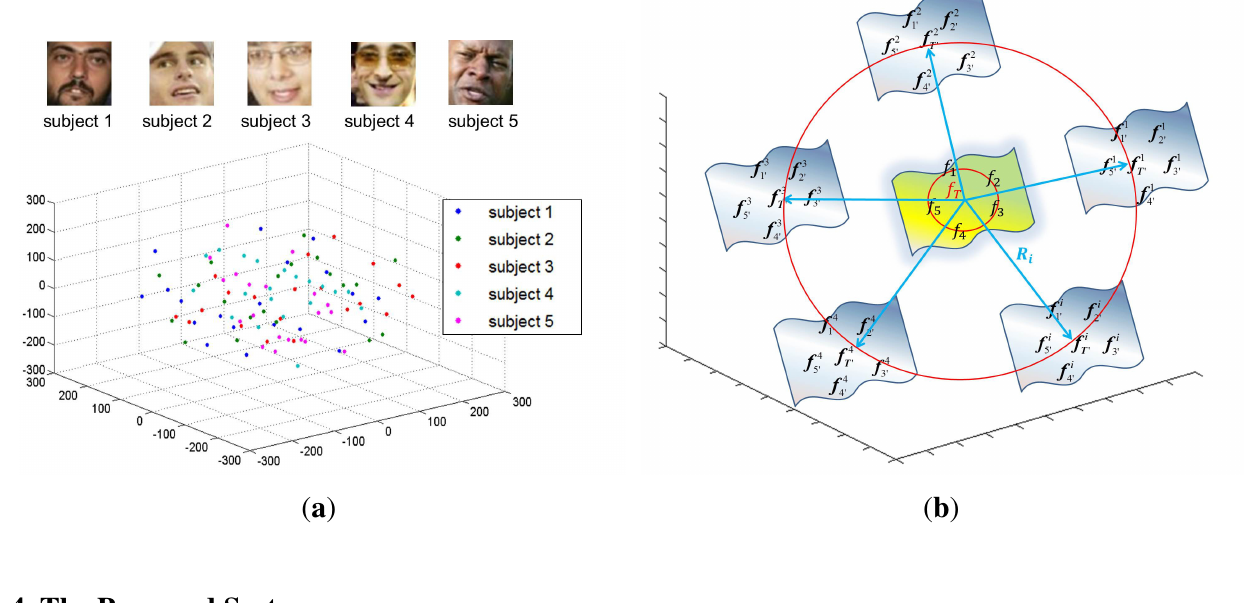
Figure 3. The motivation of this paper: ( a ) Generic distribution of face images in the manifold face space described by the first three coordinates of locality preserving projections (LPP) [29]; Two-dimensional face images are mapped into the manifold face space based on liner embedding; ( b ) Face space expansion by generating new samples based on a generic